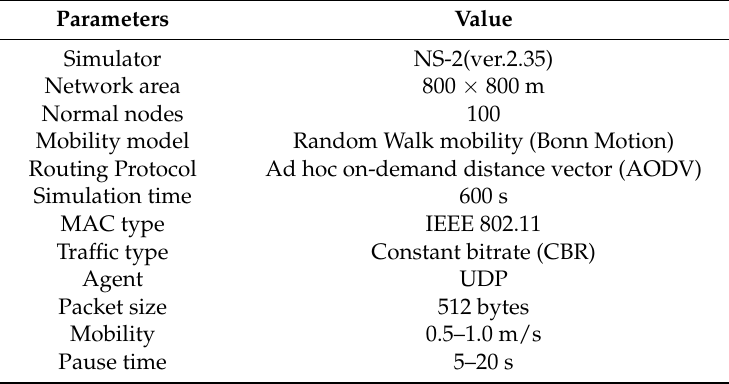
Table 3. The simulation parameters.